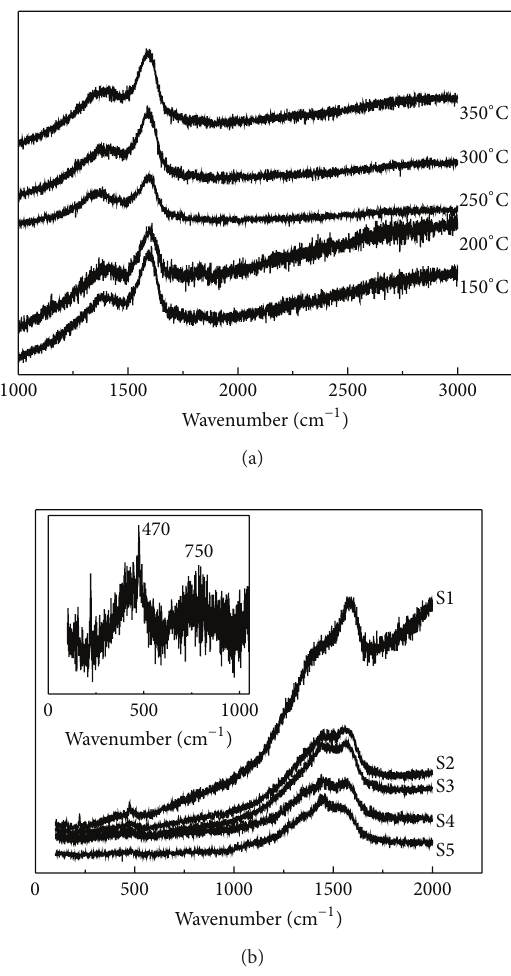
Figure 2: Raman spectrum of (a) carbyne treated at different tem- peratures, (b) S1, S2, S3, S4, and S5; inset is a partial magnification for the spectrum of